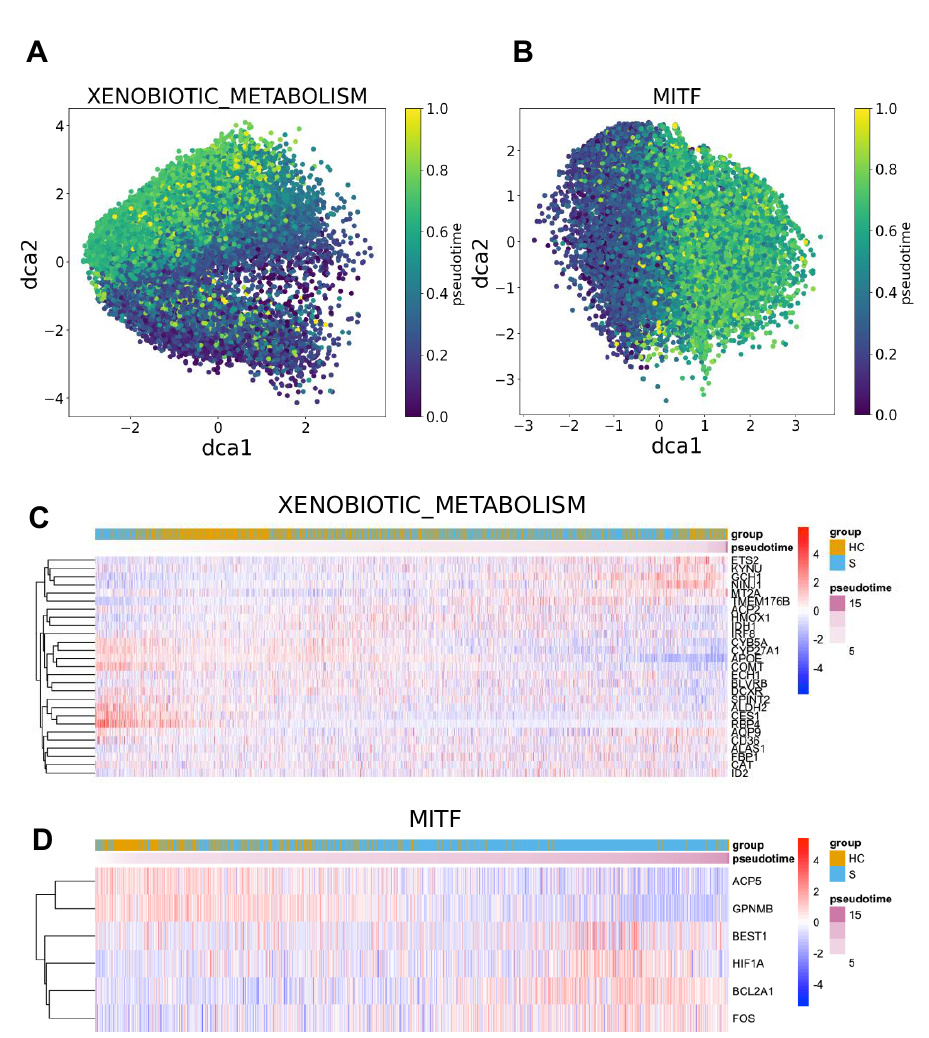
Figure 4. Visualization of both manifold and gene expression change of top transcriptional programs of the severe trajectory in macrophages. ( A , B ) A cell manifold of xenobiotic metabolism pathway and MITF transcription factor performed by DCA, respectively. X- and y-axes indicate the first and second dimensions of the gene manifold. Each point indicates a cell and is colored by its pseudotime. ( C , D ) Gene expression heatmaps for the top transcriptional programs (xenobiotic metabolism pathway and MITF ). The transcriptional program genes expressed in less than 20% of cells, or the cells showing less than 40% of expressions of the transcriptional program’s genes were excluded during the heatmap visualization.